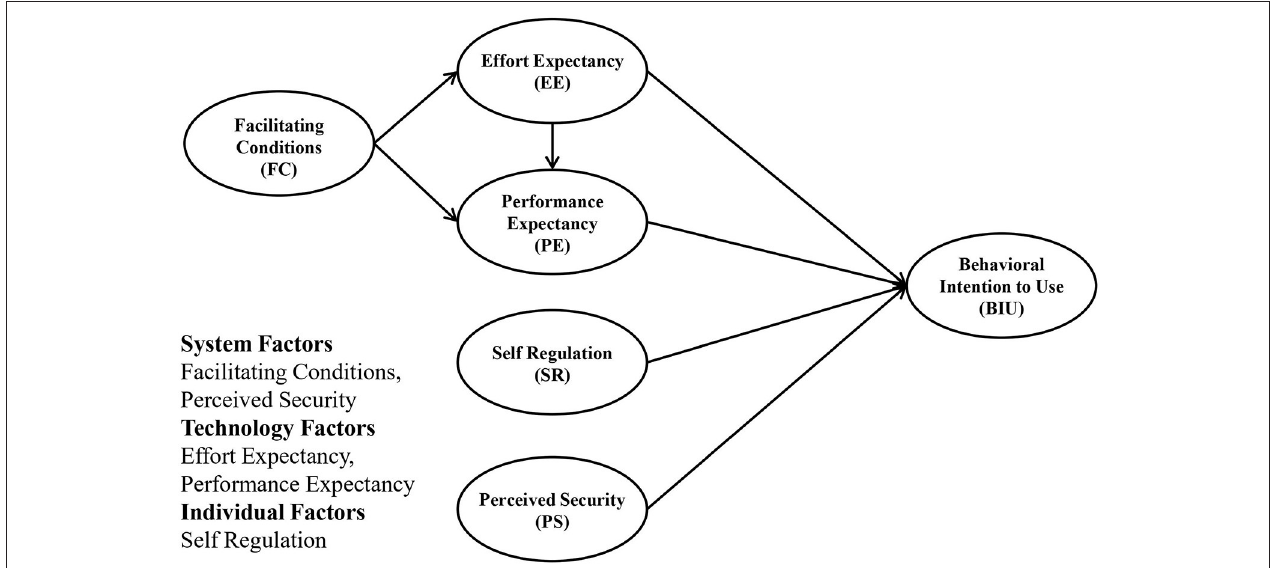
FIGURE 1 | Modified study